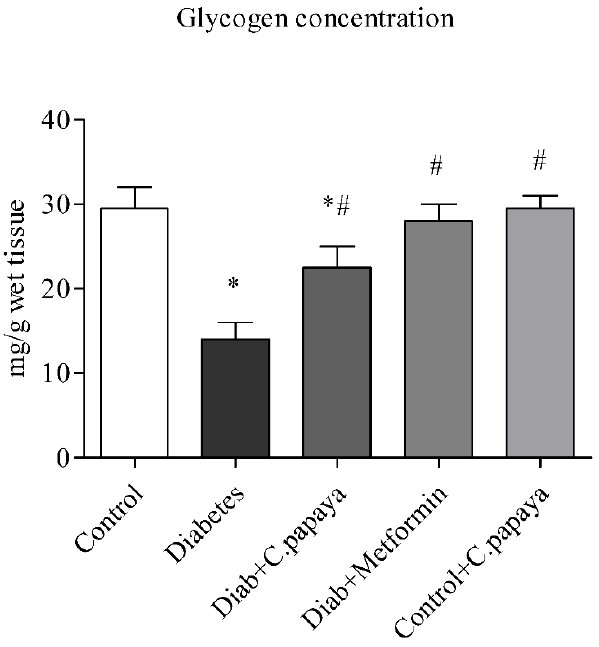
Figure 5. Role of C. papaya on hepatic glycogen concentration level. p < 0.05 was considered statistically significant among the groups: *-control; #-diabetes.